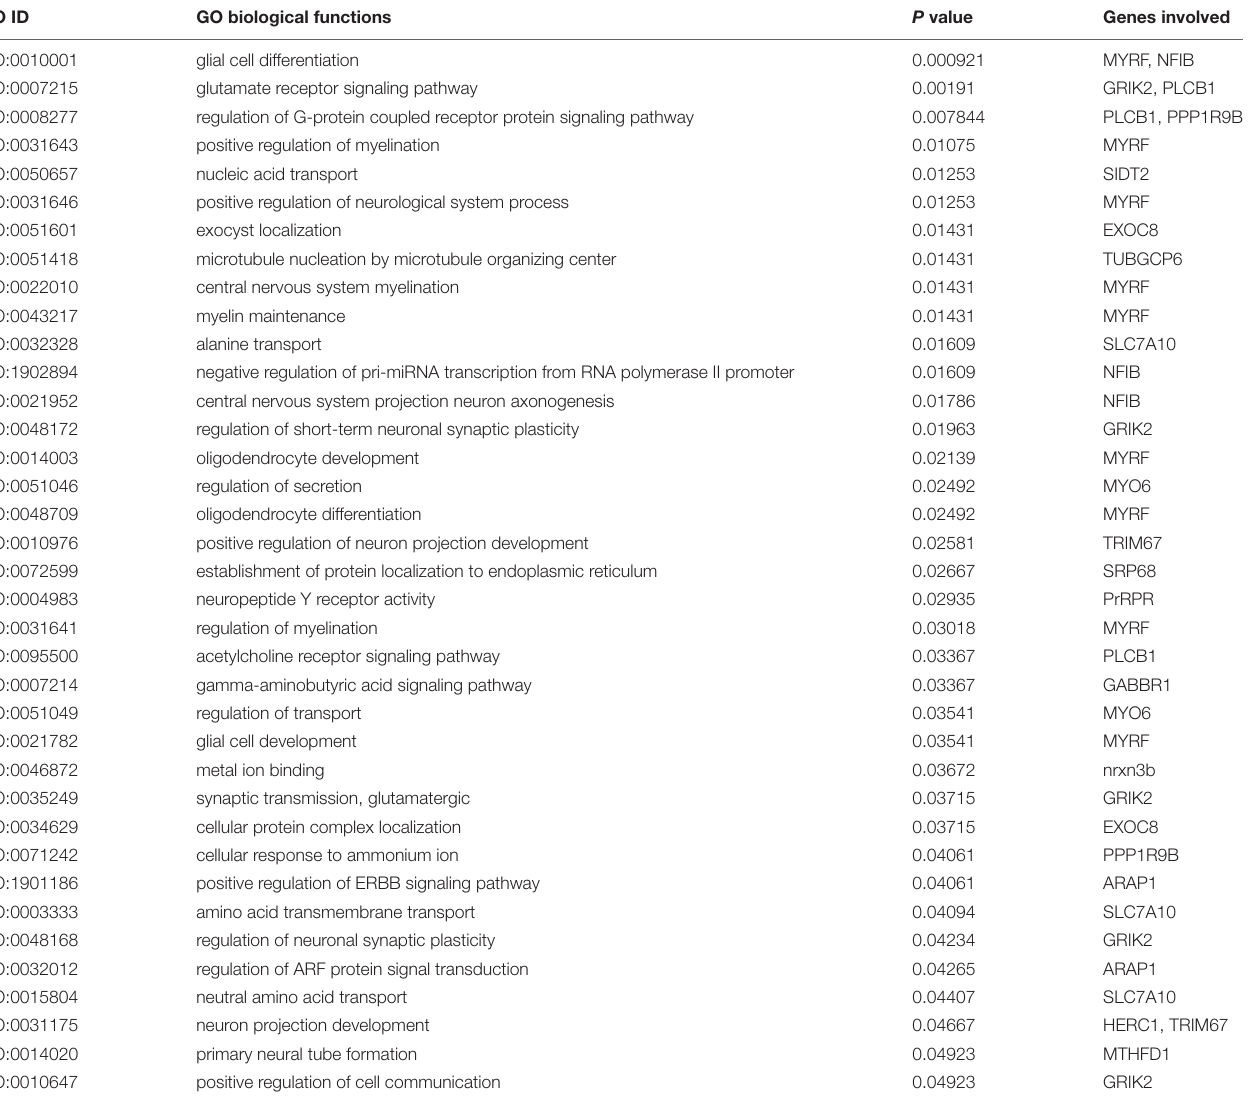
TABLE 2 | Gene Ontology (GO) terms pertaining to the homeostasis and osmoregulation related functions of the genes encoded by the putatively adaptive panel of the SNP loci of T. ilisha populations. GO ID GO biological